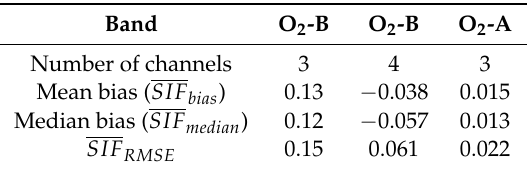
Table A3. Mean, median, and RMSE of the retrieval error on SIF at 687 nm (O 2 -B) and 760 nm (O 2